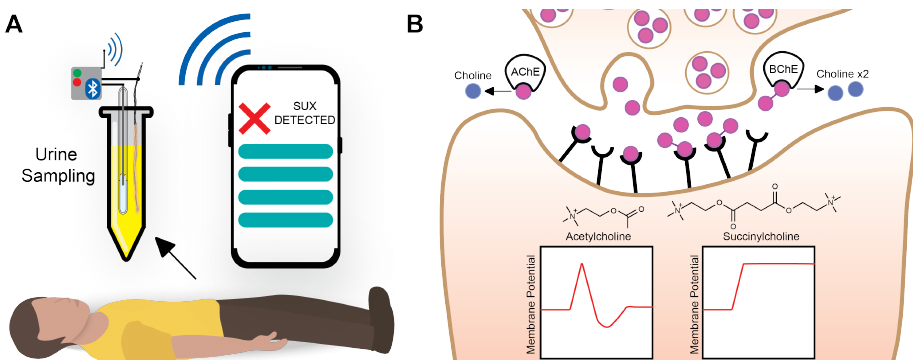
Figure 1. ( A ) At the scene of an investigation or during an autopsy, a urine sample can be obtained via a catheter or syringe and deposited into a container. The proposed thread-based ISEs can be placed into the urine with a reference electrode and wireless transducer to perform readout to a smartphone. A simple app can be coded to display the positive/negative presence of SUX, the concentration of SUX, and more detailed information about the device calibration and current emf reading. ( B ) The biological mechanism of SUX action. The dimer outcompetes acetylcholine for receptor sites and causes prolonged polarization of the neuron, leading to paralysis